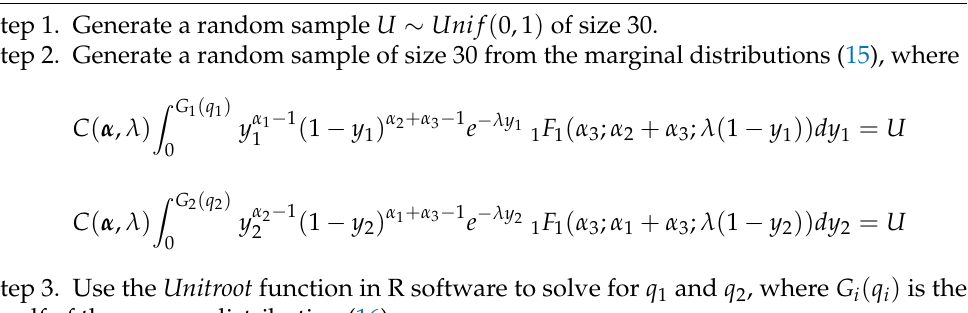
Algorithm 4 Generation of observed data for the EM